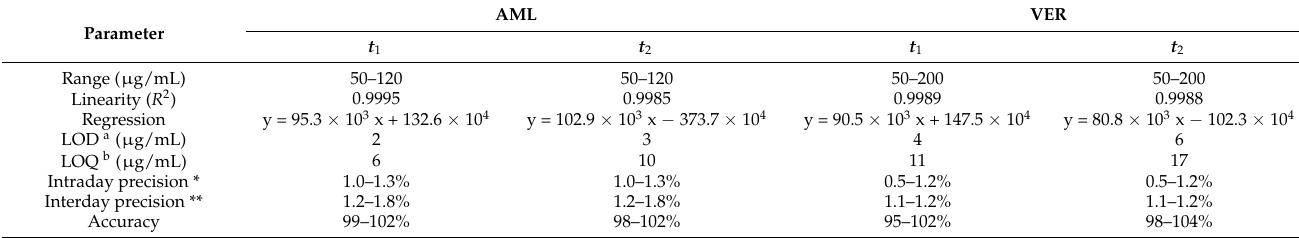
Table 2. Validation of the enantioseparation method using immobilized-CSA